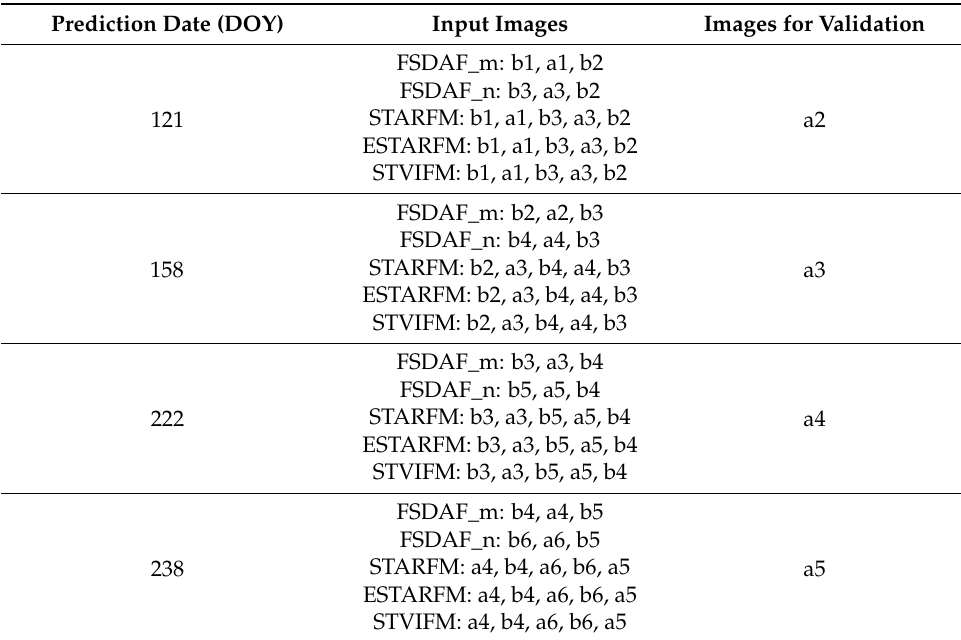
Table 4. Images used for the four methods in the four